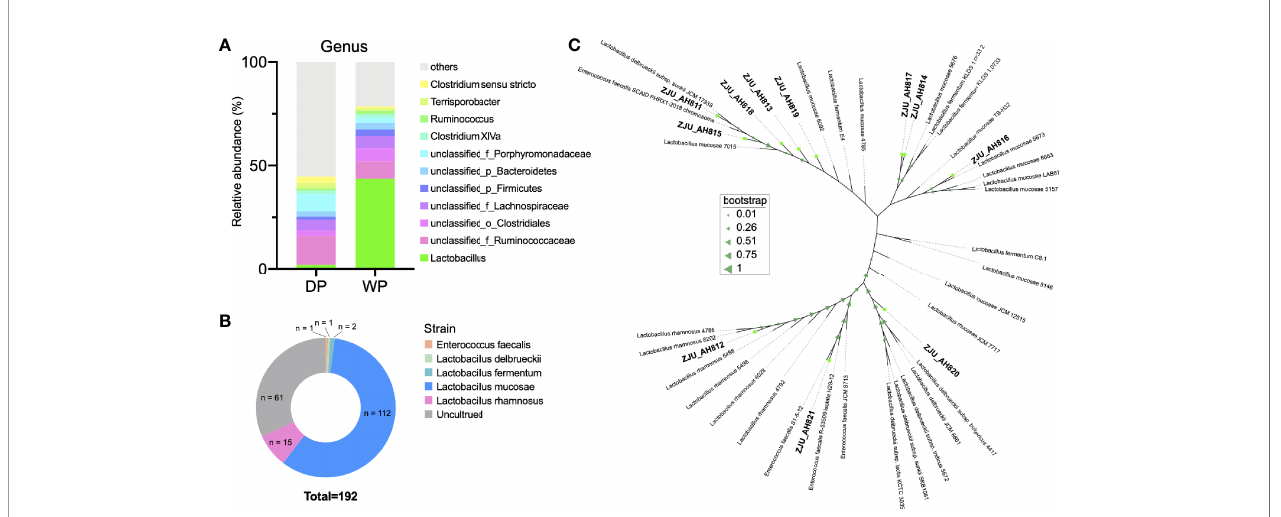
FIGURE 1 | Isolation and identi fi cation of lactic acid bacteria (LAB) strains. (A) Relative abundance (>1%) of gut microbiota at the genus level between domestic pig (DP) and wild pig (WP). (B) Proportion of the cultured LAB strains isolated from WP. (C) Phylogenetic tree of 11 LAB strains with similarity < 97%